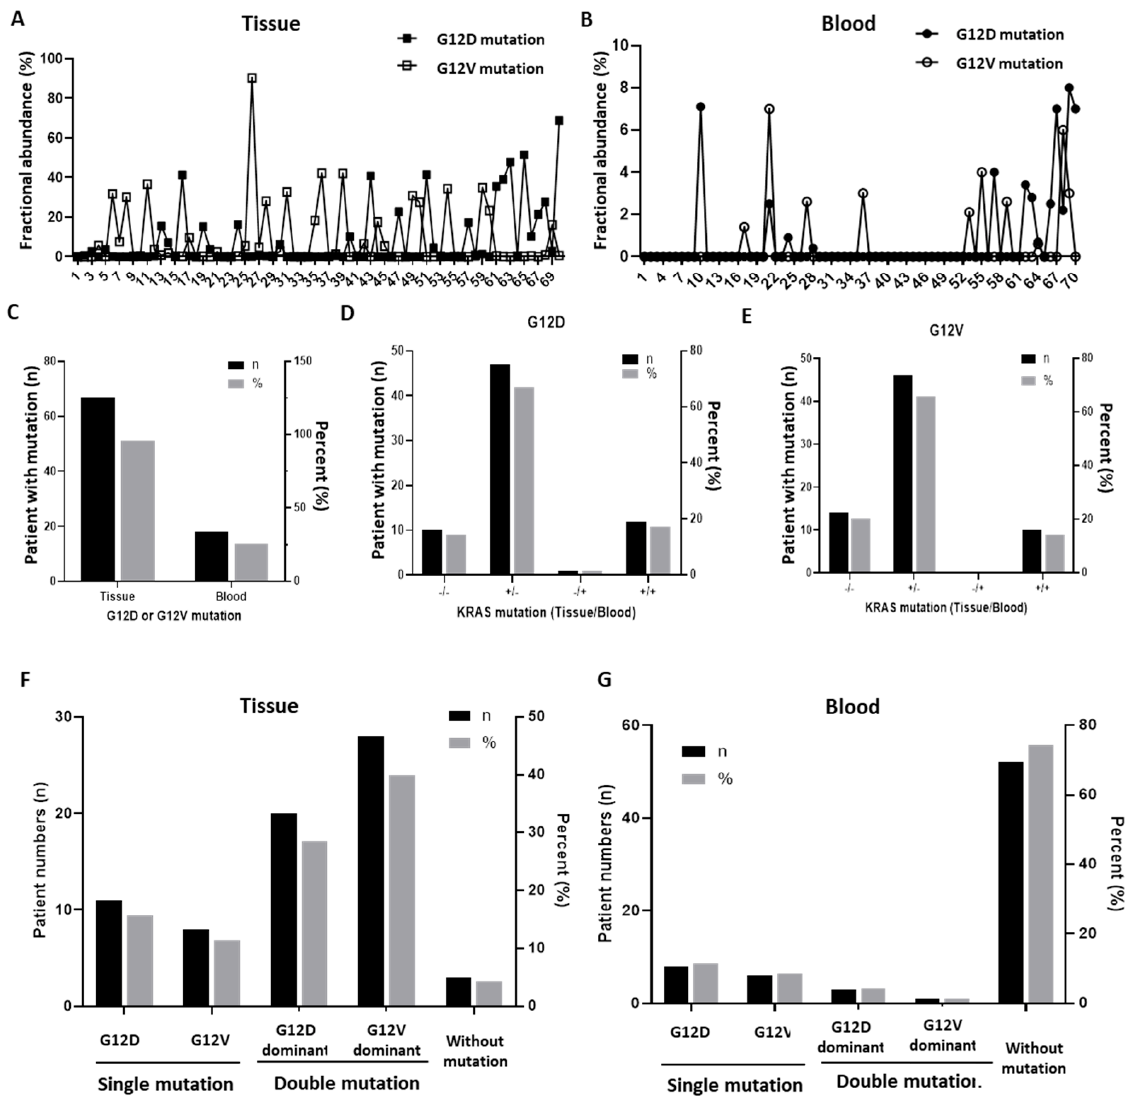
Figure 1. The presence of KRAS G12D/G12V mutations in tissues and blood ( n = 70). ( A ) Fractional abundance of KRAS G12D and G12V mutations identified in tumor tissues. ( B ) Fractional abundance of KRAS G12D and G12V mutations identified in blood. ( C ) Overall frequency of the expression of G12D or G12V mutations in tissues and blood. ( D ) Frequency of the expression of the G12D mutation by resource in tissues and blood. ( E ) Frequency of the expression of the G12V mutation by resource in tissues and blood. ( F ) Comparison of the dominance of the expression of G12D and G12V mutations in tissues. ( G ) Comparison of the dominance of the expression of G12D and G12V mutations in blood.